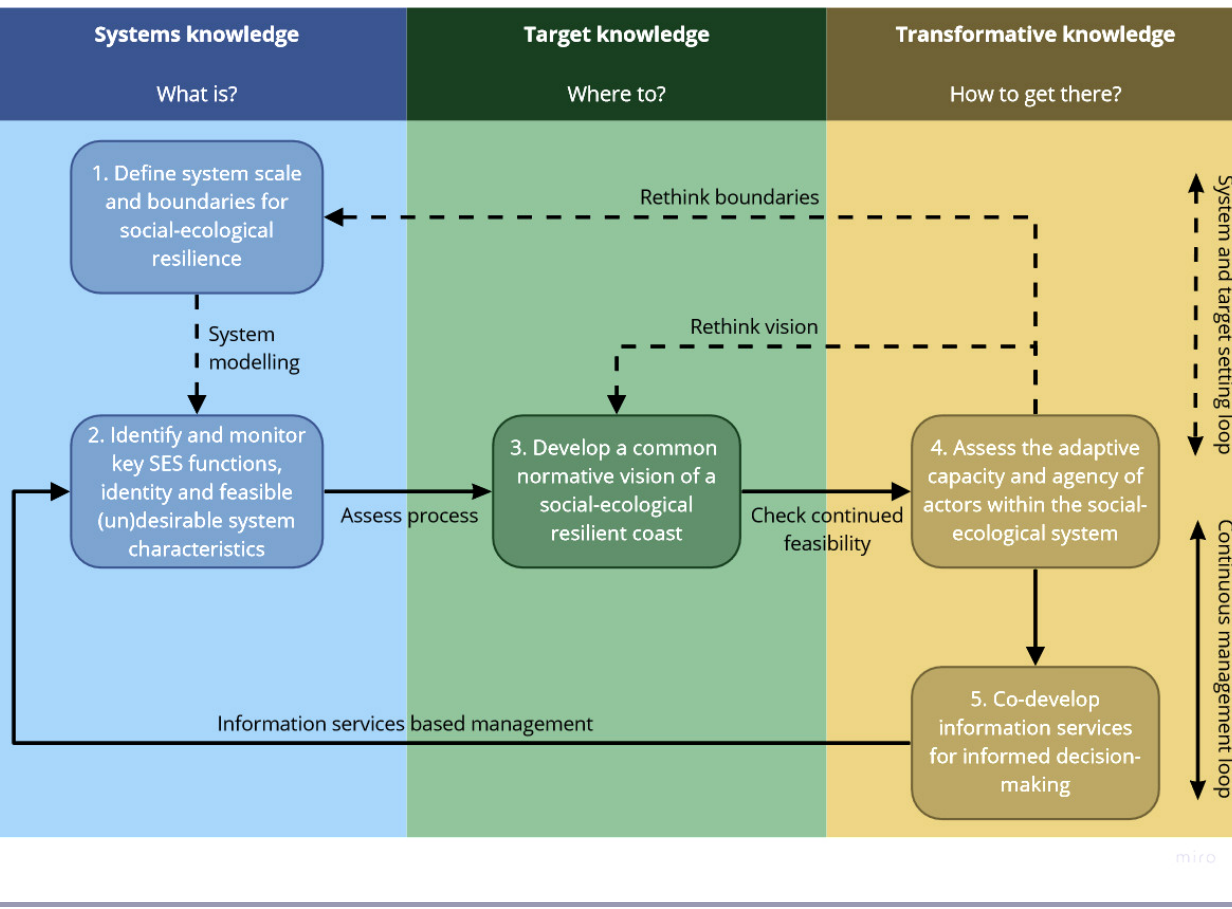
Fig. 2 . Addressing social-ecological resilience in coastal SES, based on systems, target, and transformative knowledge. The order of steps is indicated by numbers, and iterative learning cycles are indicated by straight and dashed